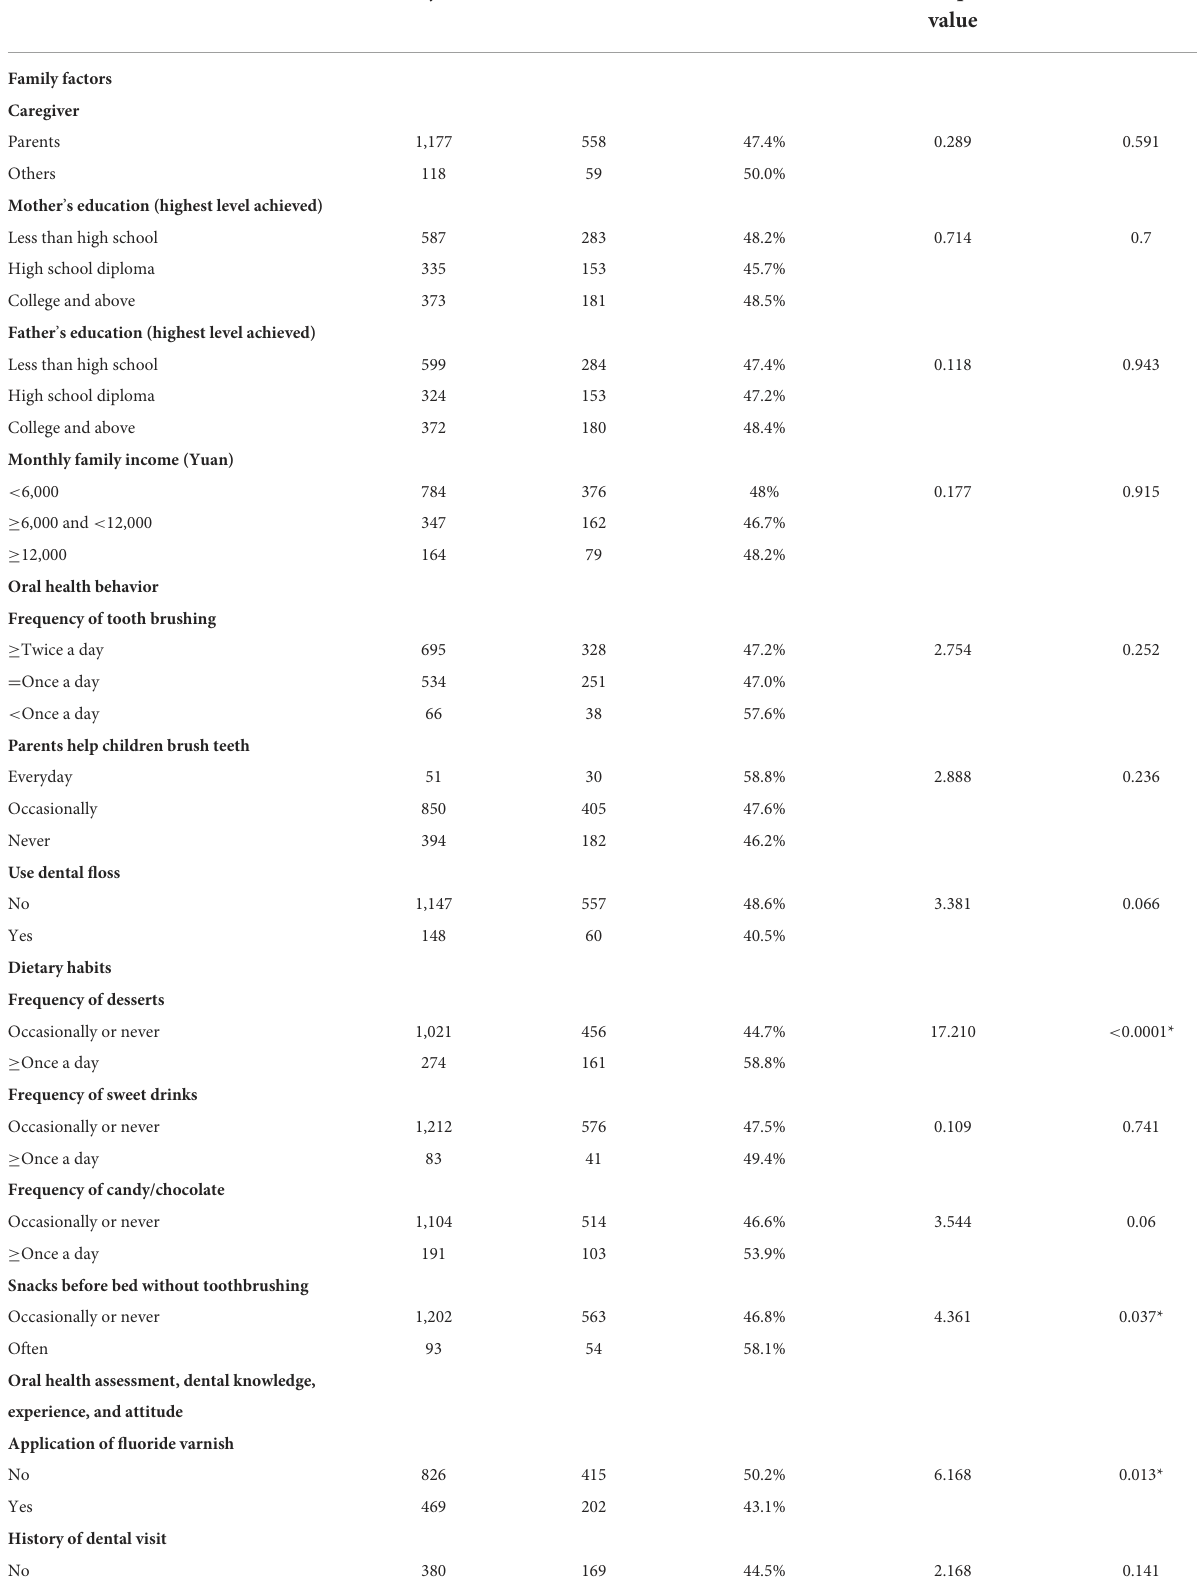
TABLE 3 Prevalence of dental caries of first permanent molar and associated factors according to the questionnaire ( N = 1,295). Variables Subjects N Prevalence (%) Chi-square